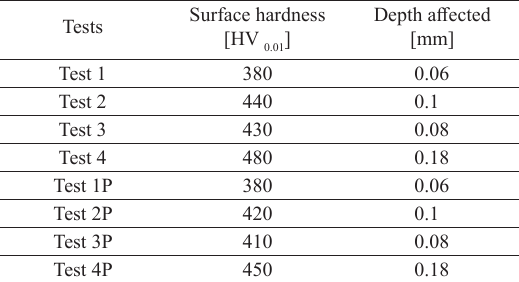
Figure 7. Hardness values of samples - Test 4 and Test 4P. Table 3. Summary of hardness and depth results affected by